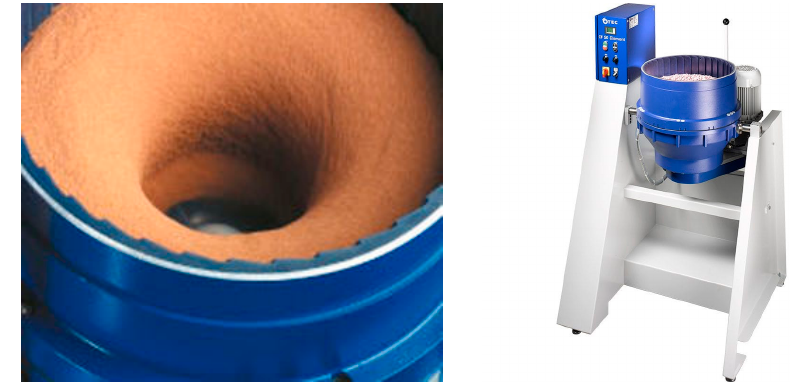
Figure 1. Centrifugal disc machine principle (LJMU).